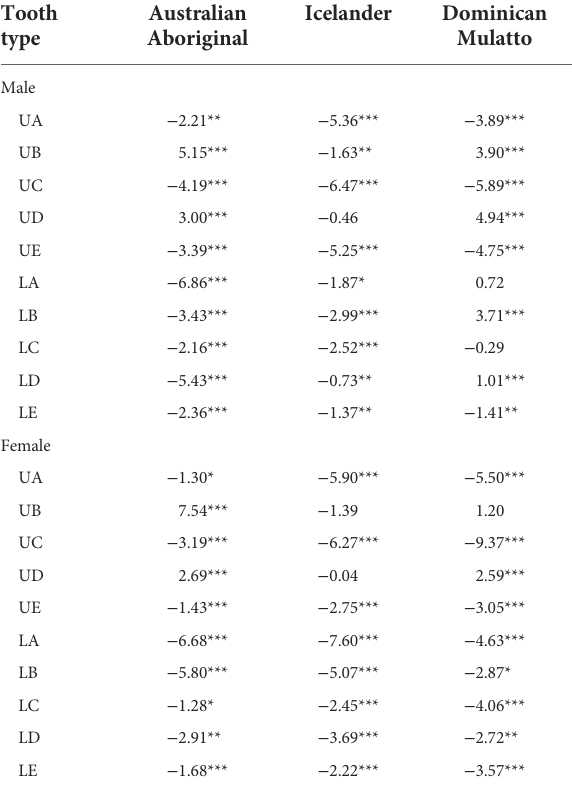
TABLE 12 Difference between the crown area of the primary teeth of northwest Chinese and those of the other populations.